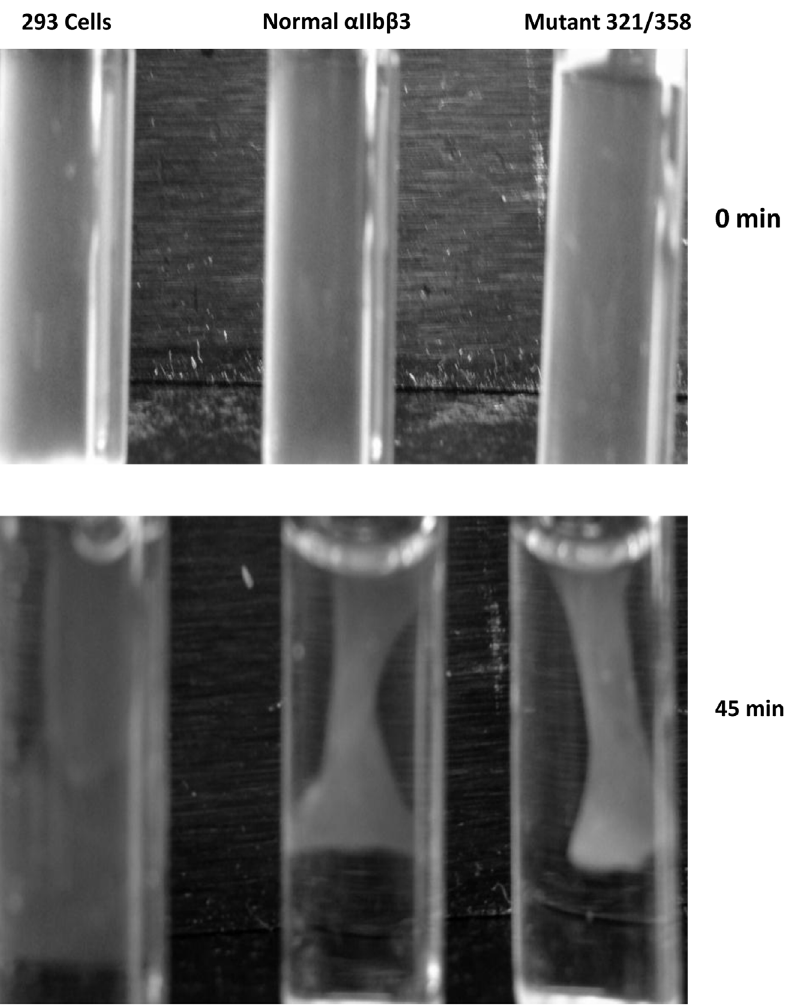
Figure 8. Cells expressing XS-O mutant 321/358 can retract fibrin clots. Untransduced cells (control 293 cells), cells expressing normal a IIb b , and cells expressing XS-O mutant 321/358 were incubated with 200 m g/ml fibrinogen and 2 U/ml thrombin at 37 u C. Clot retraction was monitored by photography at timed intervals up to 4 hr. The 45 min time point is shown since maximal clot retraction was achieved at this time. Figure S3 The effects of DTT on XS-O mutants. HEK293 cells expressing normal a IIb b 3 or XS-O mutants 321/358 and 321/360 were either untreated or treated with different concen- tration of DTT at 37 u C for the indicated times. Cells were lysed with Triton X-100 after DTT treatment and proteins were separated by SDS-PAGE and immunoblotted with anti- a IIb antibody PMI-1. The 321/358 mutant cross-linked heterodimer showed marked dissociation when reacted with 3 mM DTT for 5 min and virtually complete dissociation with 5 mM DTT for 5 min. In contrast, the 321/360 demonstrated only minimal dissociation with 3 mM DTT and moderate dissociation with 5 mM for 5 min. Increasing the DTT concentration to 30 mM and lengthening the time of incubation to 30 min were required to achieve complete dissociation. Figure S4 Heterodimer formation of mutant FF321/358 and FF 321/360. HEK293 cells expressing normal a IIb b 3 or the mutant receptors were biotinylated and lysed, and then the lysates